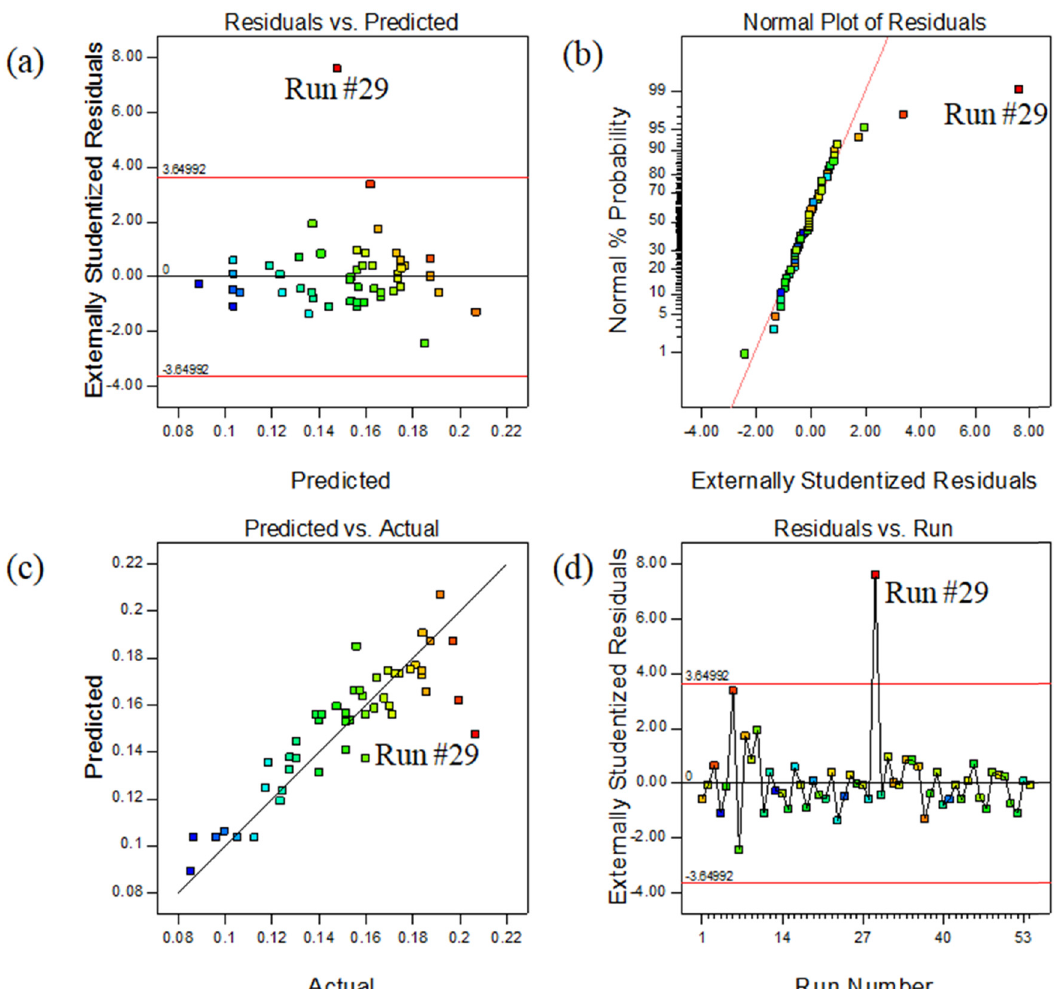
Figure 4: ( a ) Externally studentized residuals vs the predicted temperature, ( b ) normal% probability and externally studentized residual plot, ( c ) predicted vs experimental temperature, and ( d ) outlier t